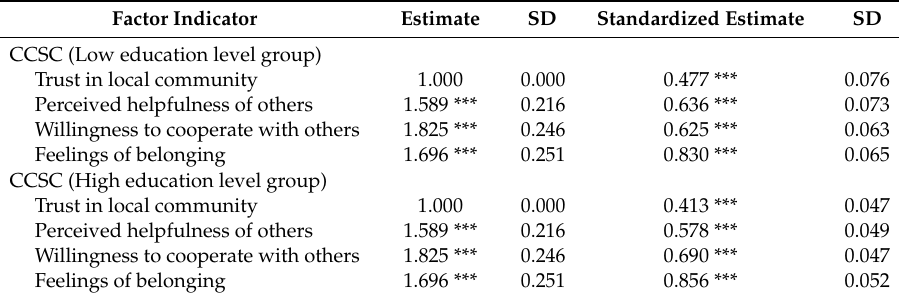
Table 2. Measurement model of CCSC.